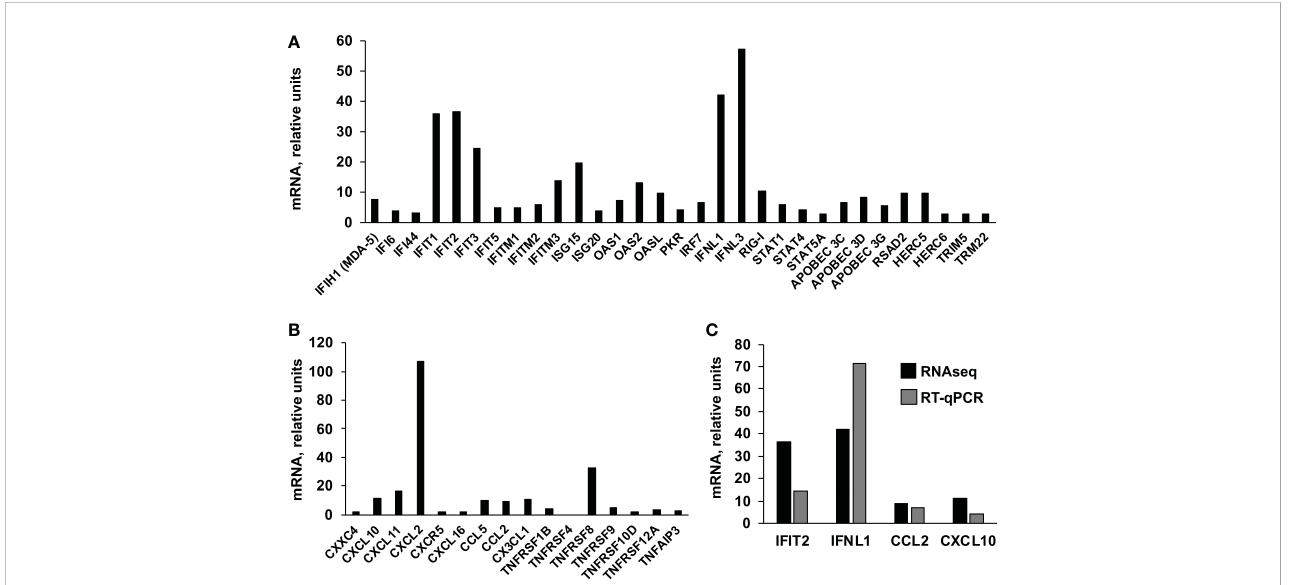
FIGURE 3 Effect of IFI6 on host gene expression. HAP-1 control and IFI6 KO cells were either mock-treated or treated with poly(I:C). Total RNAs were extracted and the cellular transcriptomes were analyzed by RNAseq. The ISGs (A) and genes encoding proin fl ammatory cytokines (B) which are differentially upregulated in HAP-1, IFI6 KO, poly(I:C)-treated cells compared to HAP-1, control, poly(I:C)-treated cells, are represented. (C) Comparison of the levels of expression of IFT2 (an ISG), IFNL1 (a type III IFN), CCL2 and CXCL10 (two pro-in fl ammatory cytokines), as measured by RNAseq and